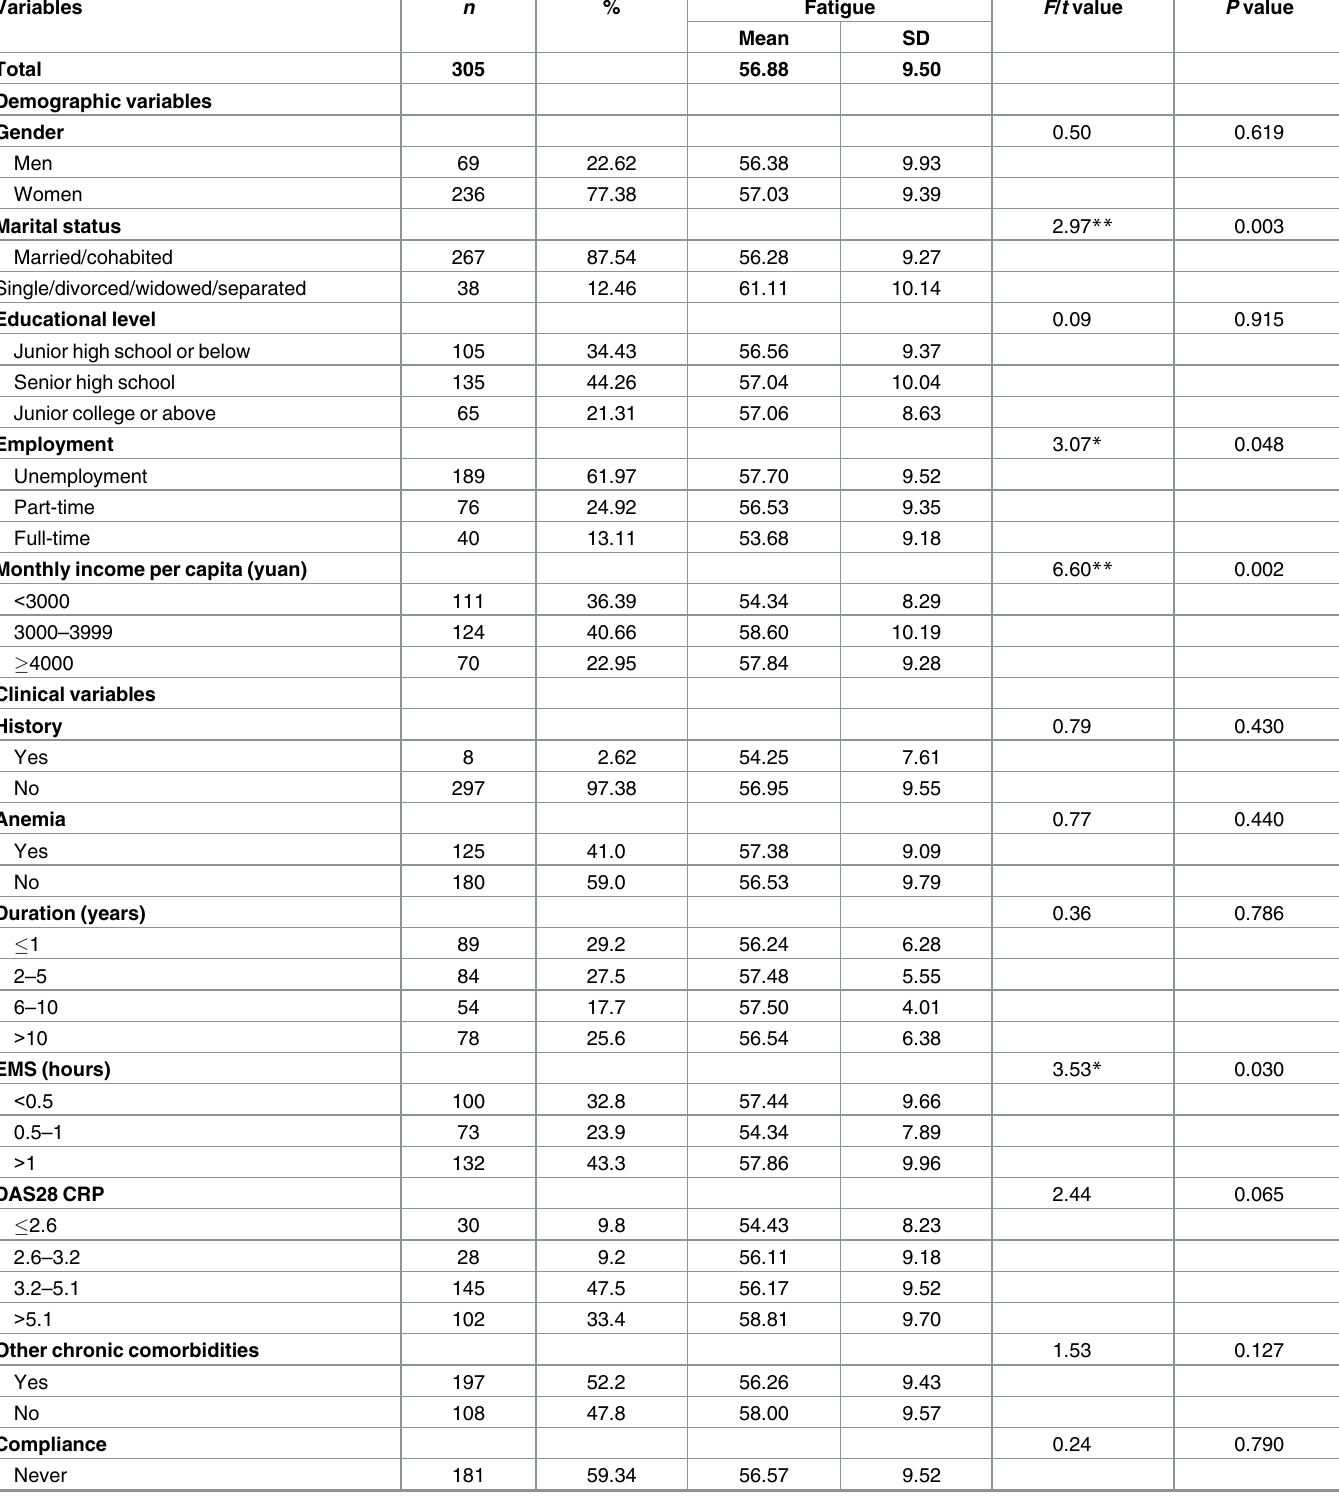
Table 1. Demographic and clinical characteristics and group differences of